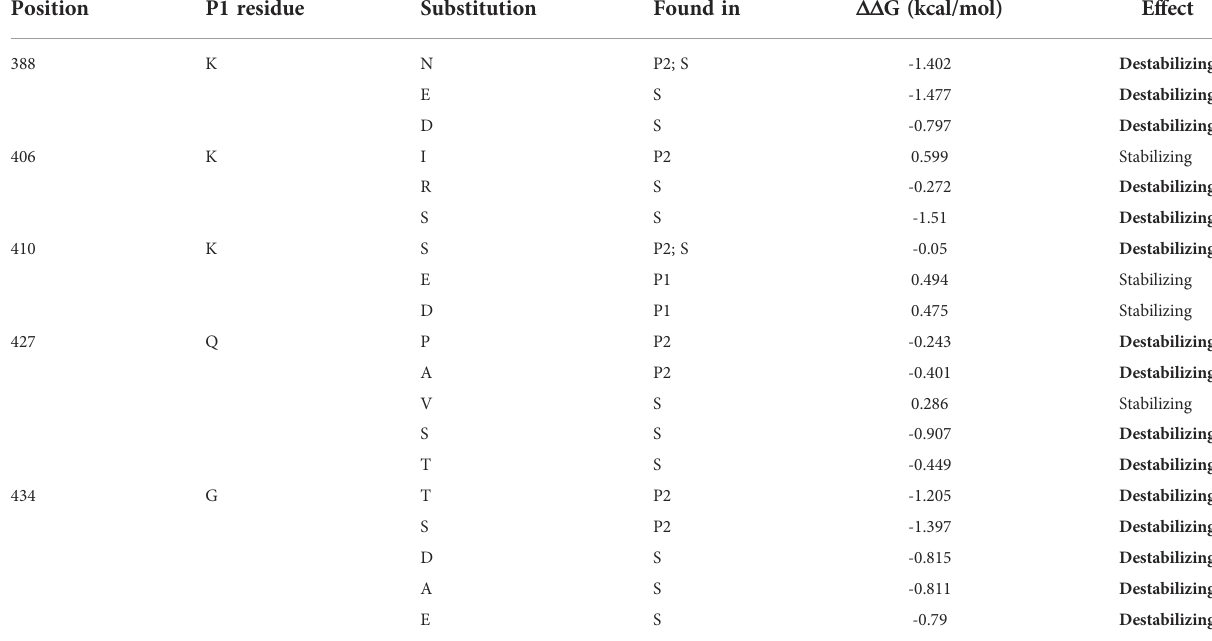
TABLE 1 Effects of residue variations on leptolysin catalytic site stability. Position